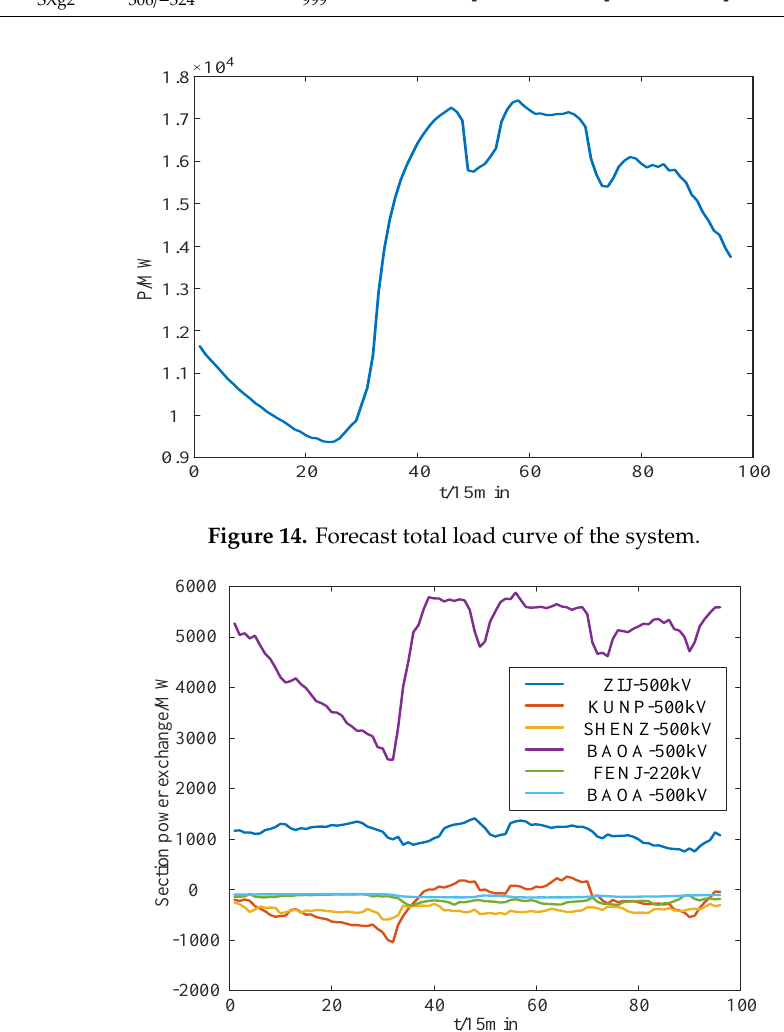
Figure 15. Power scheduling of interchange sections with outside systems. Table 10. Security limits of several key transmission sections.